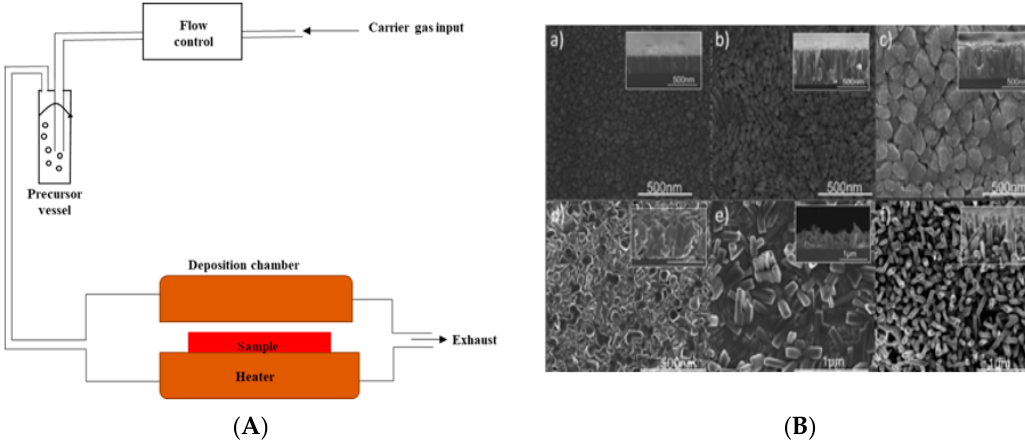
Figure 14. ( A ) Schematic diagram of a conventional CVD reactor , ( B ) SEM images of nanostructured Nb 2 O 5 thin films formed at varying substrate temperatures within the ranges of (a) 500 °C to (f) 1000 °C, in intervals of 100 °C. [130]. Reprinted with permission from [130]. Copyright 2016 ACS Publications.